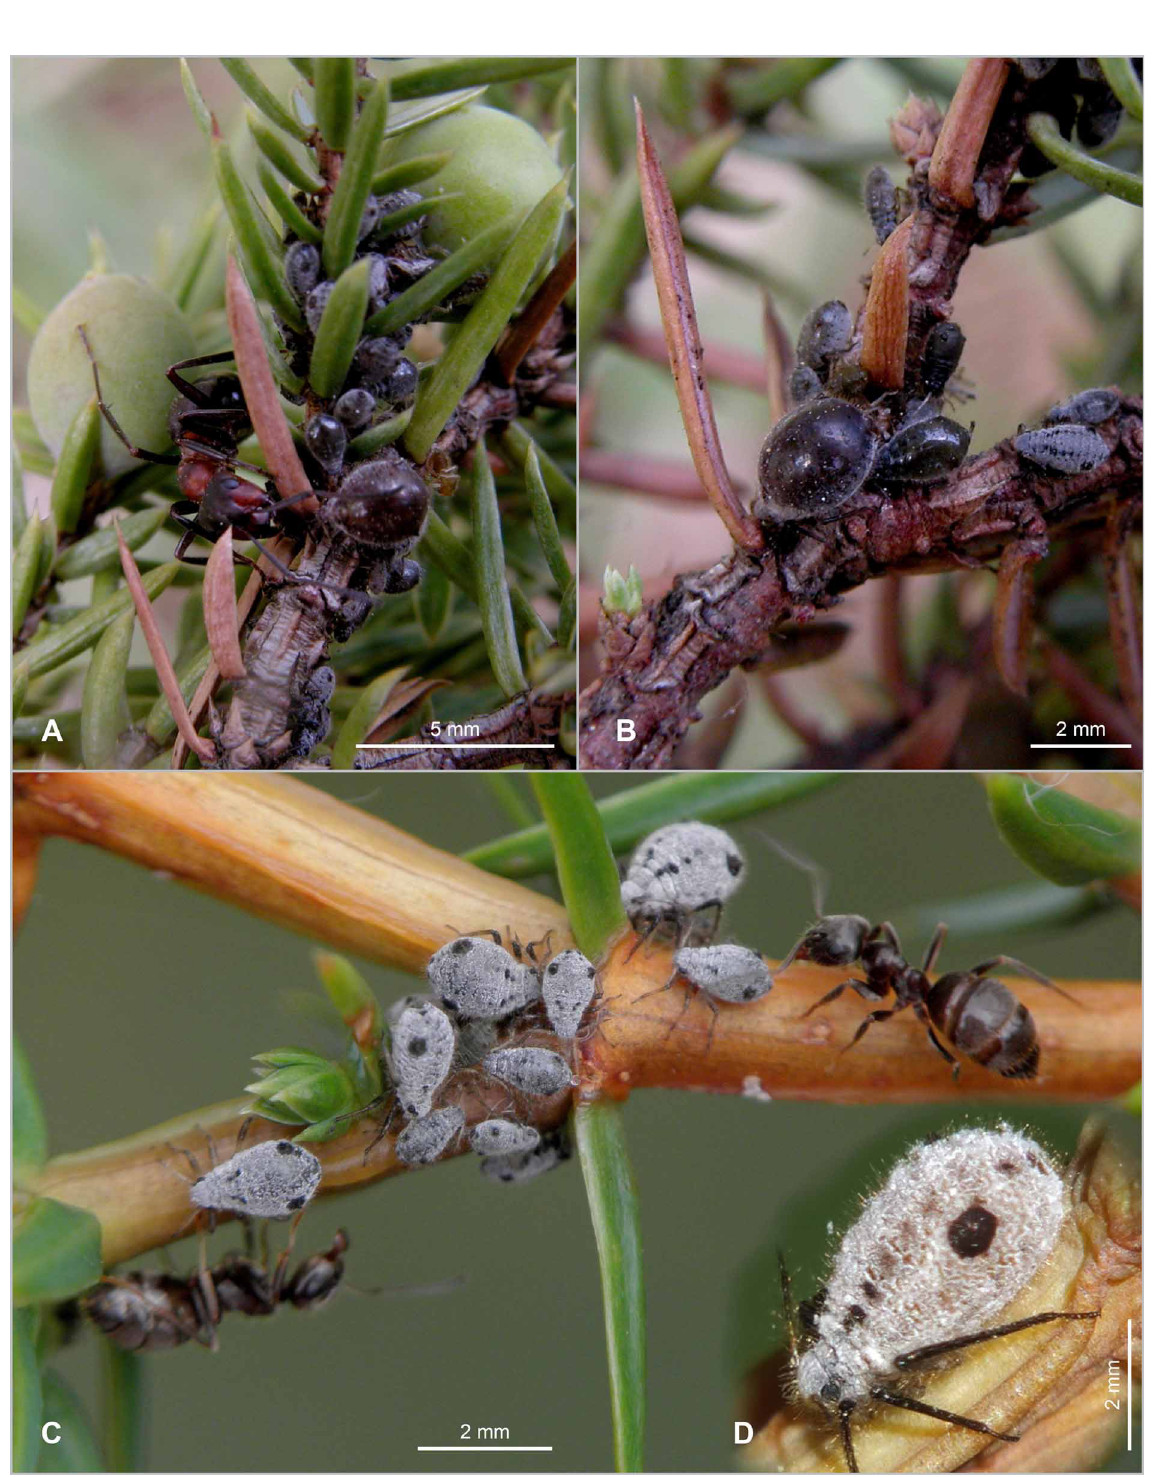
Fig. 114. Cinara (Cupressobium) juniperi (De Geer, 1773) on Juniperus communis . A–B . Fundatrix with offspring on previous year’s twig, attended by Formica rufa Linnaeus, 1761. C–D . Colony on current year’s growth, attended by Lasius niger (Linnaeus,